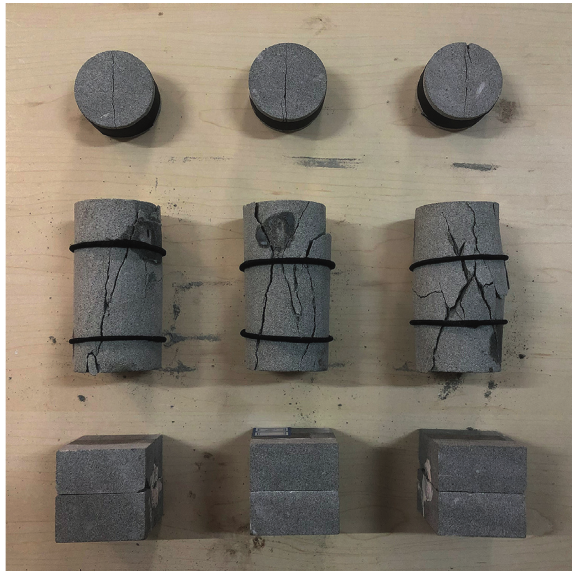
Figure 2: The failure mode of